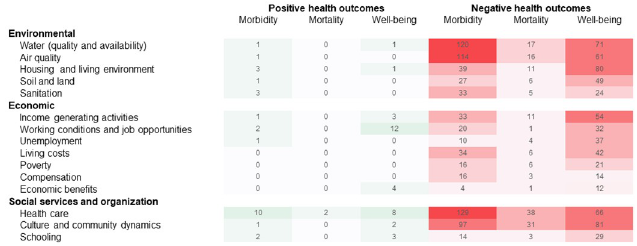
Fig 2. Qualitative matrix of perceived impacts and health outcomes. Distribution of perceived positive (green) and negative (red) impacts on the wider determinants of health and related health outcomes; colour gradient indicates coding frequency, numbers indicate coded